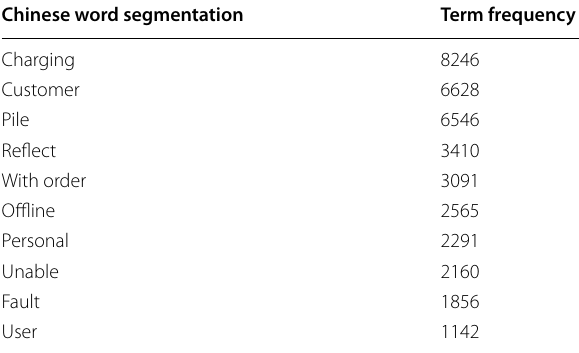
Table 4 The most 10 frequent words in dataset